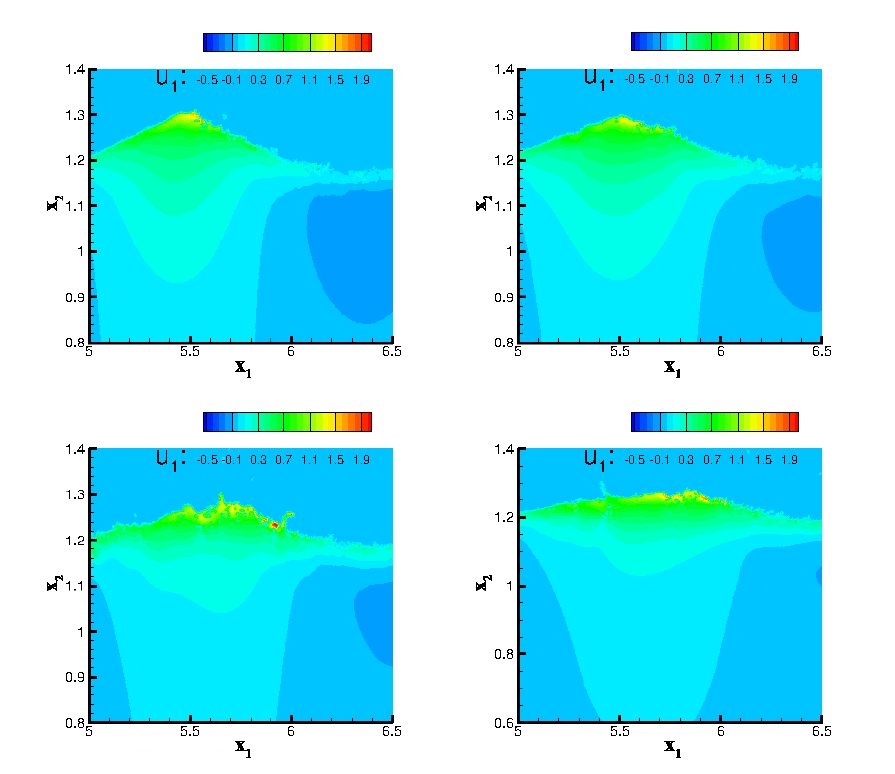
Figure 6. Instantaneous snapshots of horizontal velocity component ( u 1 [m/s]) at t = 5 [s] (left-hand side panels ) t = 10 [s] ( right-hand side panels ). The top panels correspond to the case with the wind body force f = 0.5 [N/M] and bottom panels correspond to the case with the wind body force f = 0.6